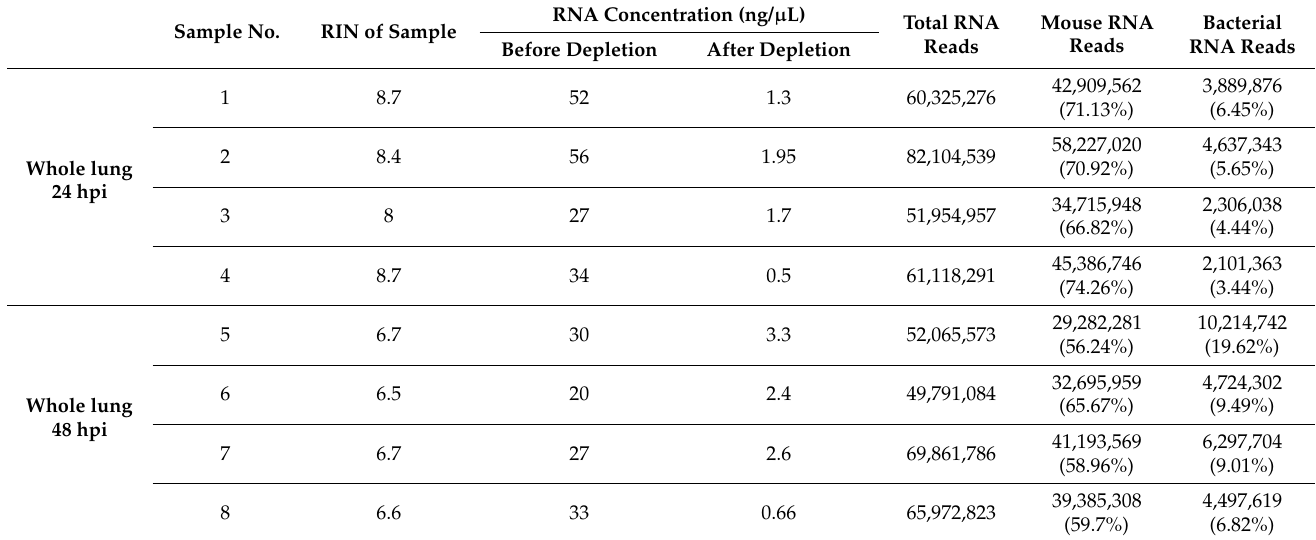
Table 1. Dual RNA samples analyzed in this study. The experiment included four mice at each time point. The RNA-seq profiles of the mice obtained using these 8 samples were deposited in the NCBI repository as individual datasets (see Materials and